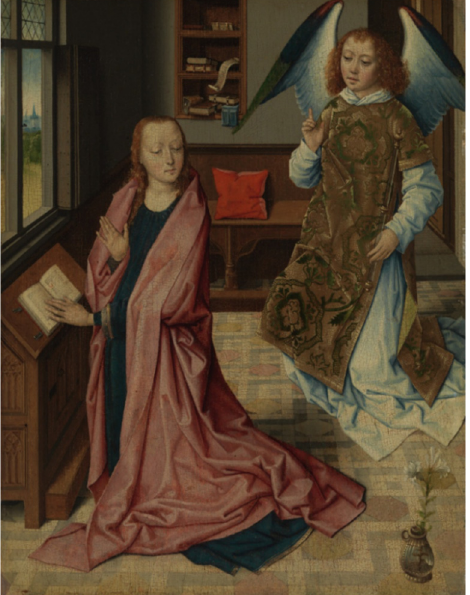
Figure 5. Workshop of Dirk Bouts, Annunciation , ca. 1480–1490. Oil on wood, 58.1 × 48.58 cm. Richmond, Virginia Museum of Fine Arts. © Virginia Museum of Fine Arts, https://www.vmfa.mu-